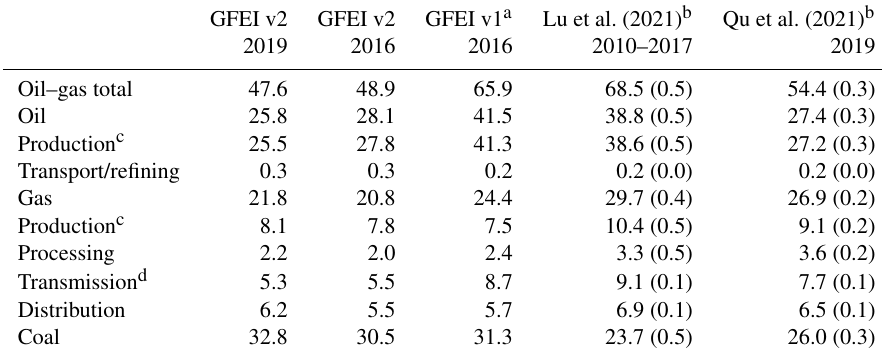
Table 1. Global methane emissions from oil, gas, and coal exploitation (Tg a − 1